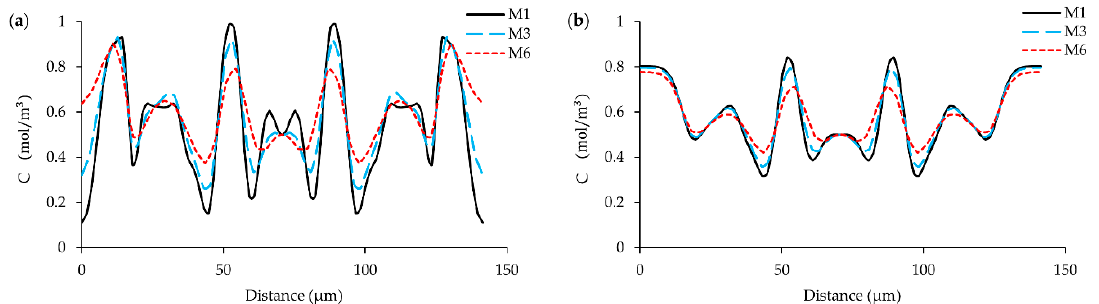
Figure 16. Concentration distribution on x-y plane at z = 500 µ m (Line-II in Figure 3) for four-inlet design at Re = 240: ( a ) D M = 3 × 10 − 10 m 2 /s and ( b ) D M = 6 × 10 − 8 m 2 /s.